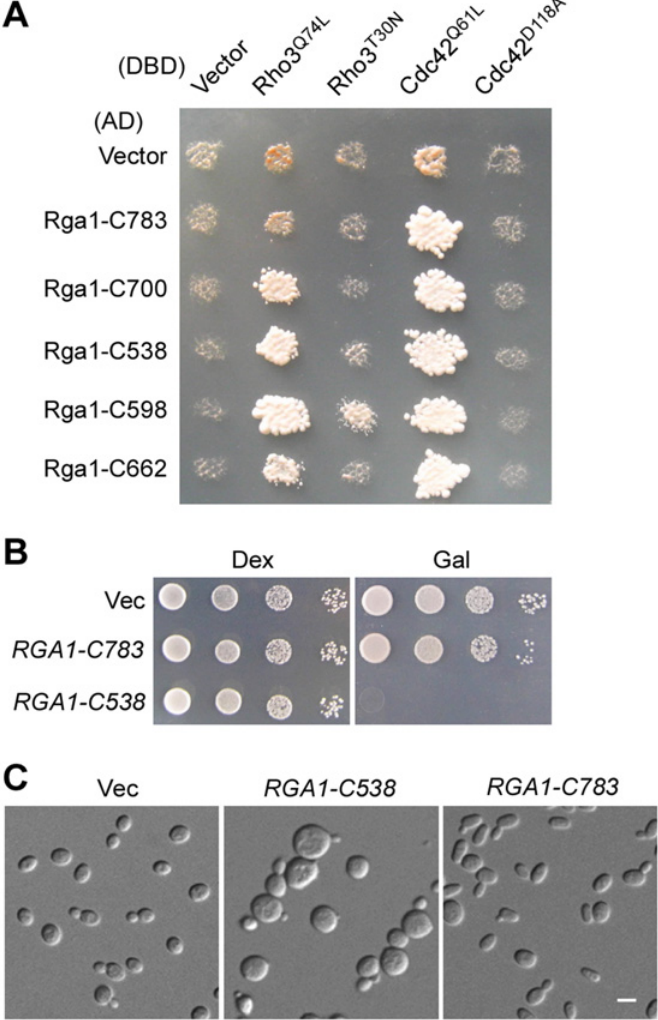
Fig 6. Interaction of Rga1 with Rho3 may require additional sequence upstream of Rga1 ’ s RhoGAP domain. (A) Two-hybrid assay of the interaction of Rga1-C segments with Rho3 and Cdc42. Cells were grown on SC-Leu-Ura-Ade plate. Picture was taken after 3 days at 30°C. Prey plasmids pGAD-C1 (AD vector) and pGAD-RGA1-C segments were used. (B) Cells of strain YEF473A carrying plasmids pEGKT306 (Vec), pEGKT306-RGA1-C538, and pEGKT306-RGA1-C783 were grown on SC-Ura (Dex) and SRG-Ura (Gal) plates for 4 days at 30°C. (C) DIC images of cells as in (B) grown on SRG-Ura plate for 16 hr at